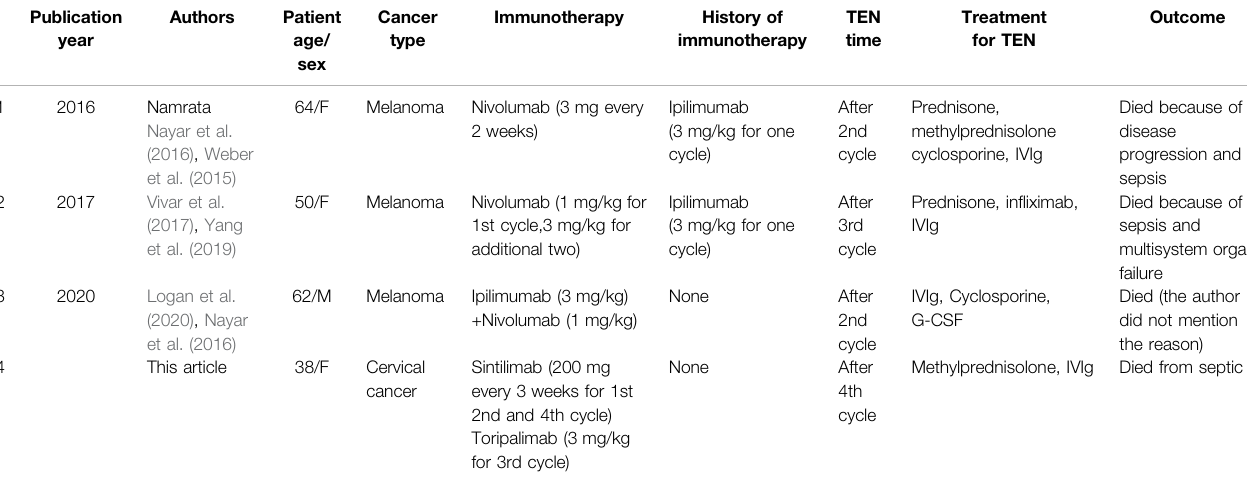
TABLE 1 | Reported cases of TEN caused by anti-PD-1 monoclonal antibodies